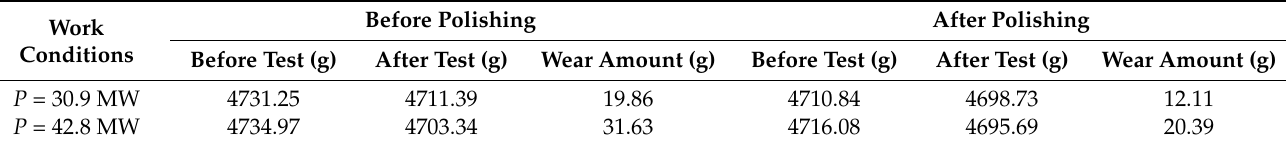
Table 4. Physical properties of tungsten